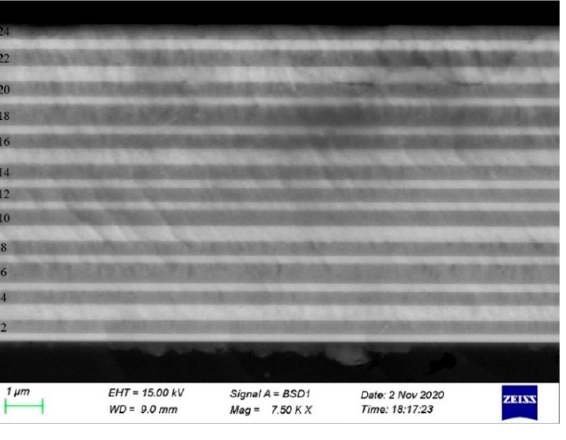
Figure 13. Cross-sectional SEM micrograph of bandpass filter structure for the region 3.55–3.75 µm . Table 2. Comparison of the film thickness between the designed and the measured multilayered filter for 3.55–3.75 µm.